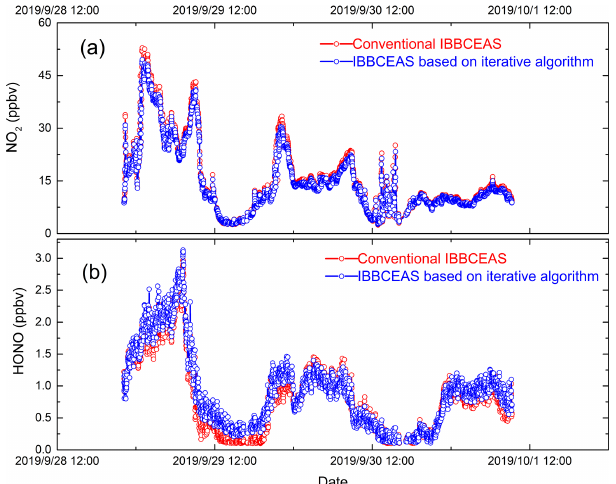
Figure 10. The time series of the (a) NO 2 and (b) HONO concen- trations measured by the two instruments. All data are 1min aver- ages. The red data point is the result of retrieval using an iterative algorithm, and the blue data point is the result of retrieval using a conventional IBBCEAS